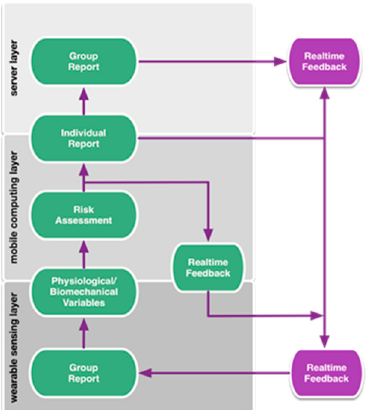
Figure 1. The proposed system architecture, hardware layers, and information flow.